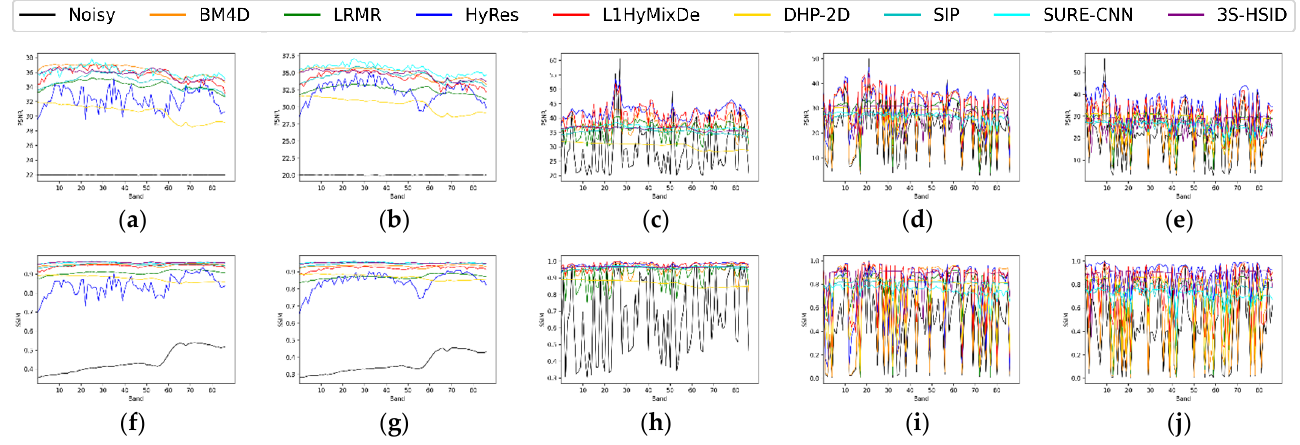
Figure 10. PSNR and SSIM values of different bands: ( a ) PSNR values of Case 1 1 ; ( b ) PSNR values of Case 1 2 ; ( c ) PSNR values of Case 2; ( d ) PSNR values of Case 3; ( e ) PSNR values of Case 4; ( f ) SSIM values of Case 1 1 ; ( g ) SSIM values of Case 1 2 ; ( h ) SSIM values of Case 2; ( i ) SSIM values of Case 3; and ( j ) SSIM values of Case 4.